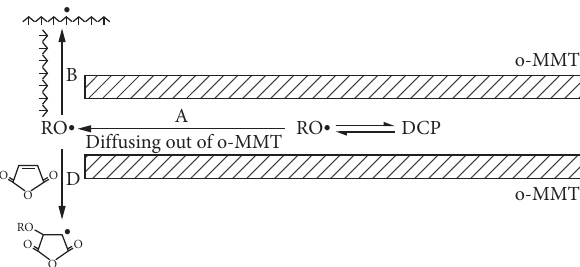
Figure 4: A simplified reaction scheme of DCP homolytic fragmentation and diffusion in